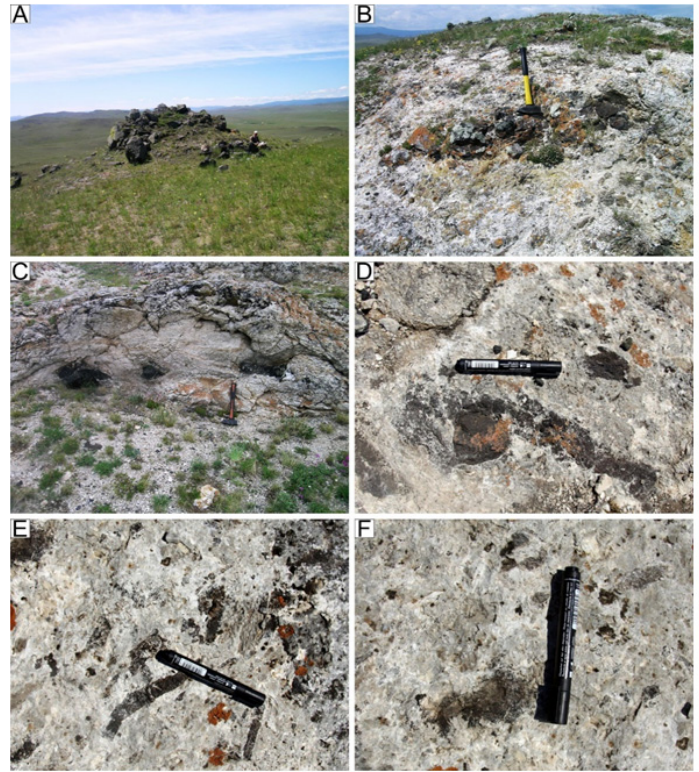
Figure 5. Pyroxenite in marbles. ( A ) a large pyroxenite fragment (up to 15 m in diameter); ( B ) a lens of skarned pyroxenite; ( C ) a few pyroxenite fragments; ( D , E ) small fragments of skarned pyroxenite; ( F ) a fragment of skarned pyroxenite “dissolved” along the margins.